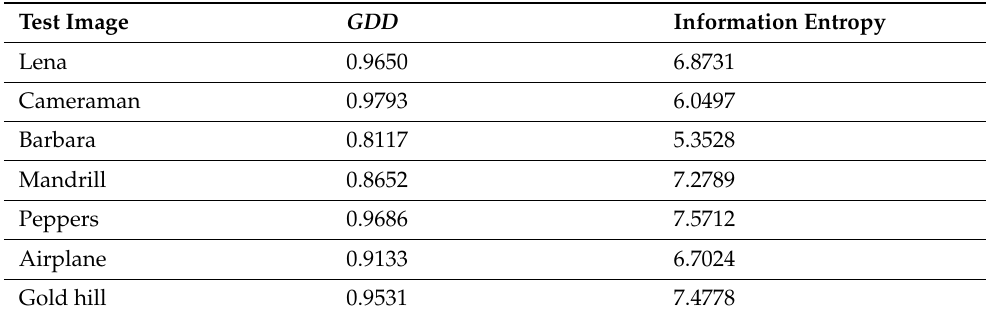
Table 4. GDD between Original Test Images and their Scrambled Versions and information entropy for encrypted images. Test Image GDD Information